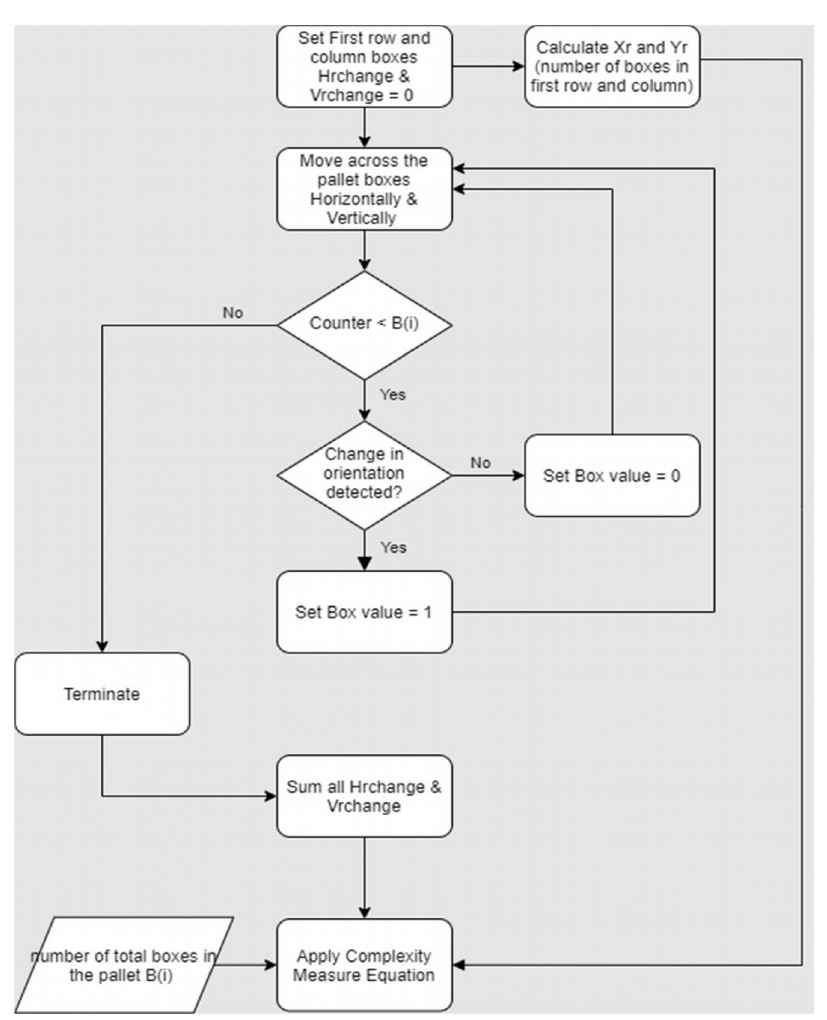
Figure 4. Complexity Measure